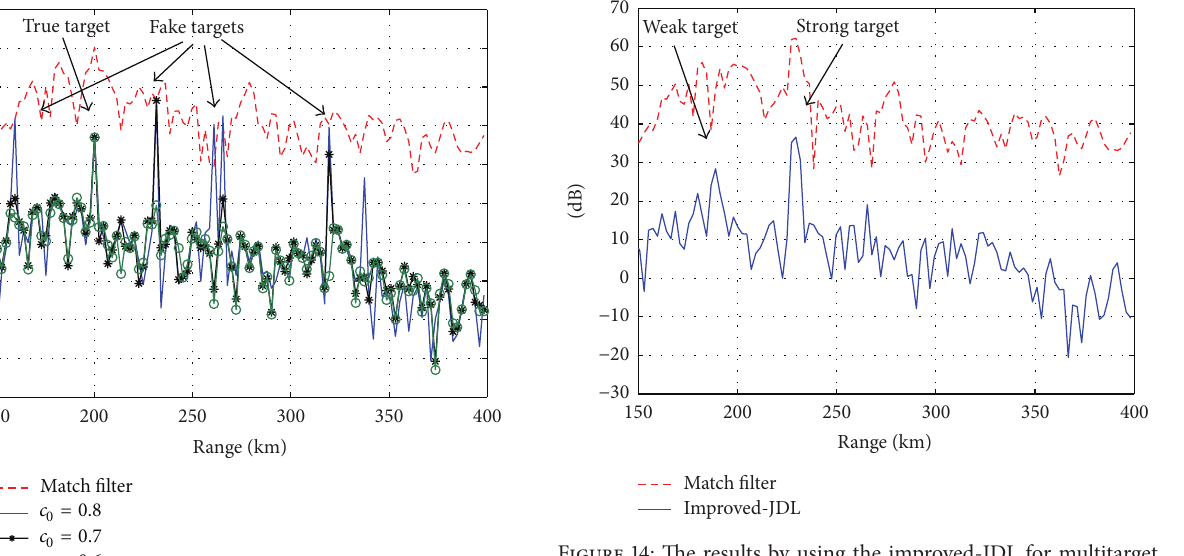
Figure 14: The results by using the improved-JDL for multitarget situation (range-spread